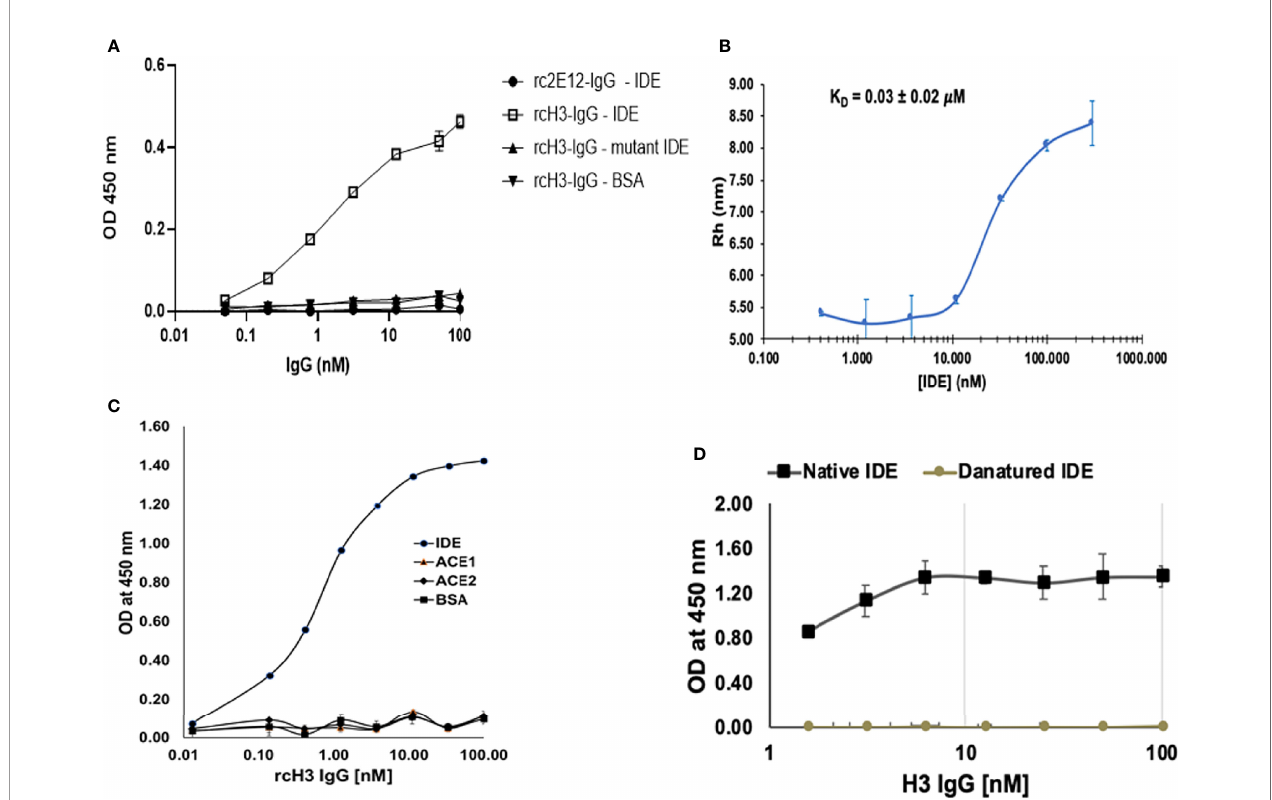
FIGURE 4 | Reverse chimeric H3 IgG binds IDE speci fi cally and in a conformation-dependent manner. (A) Evaluation of binding to WT and to mutant IDE by reverse-chimeric H3 and by the isotype control, reverse-chimeric 2E12 IgGs by ELISA. The results are presented as mean ± SEM (n = 3). (B) Binding af fi nity of rcH3 to rhIDE measured by MDS. A binding experiment of rhIDE to Alexa-647-labeled rcH3-IgG using diffusional sizing (MDS) (37). Bars show the average of triplicate measurements with the error bars representing the standard deviation. From the fi t, the dissociation constant KD = 30 nM could be calculated. (C) Speci fi city of reverse-chimeric H3 to IDE vs. ACE1 and ACE2 was evaluated by ELISA. (D) rcH3-IgG recognizes a conformational epitope on rhIDE. rcH3-IgG at concentrations of 100, 50, 25, 12.5, 6.25, 3.125, and 1.625 nM was applied to the wells of three columns of wells coated with native or with heat-denatured rhIDE. The ELISA was carried out as described in Materials and Methods